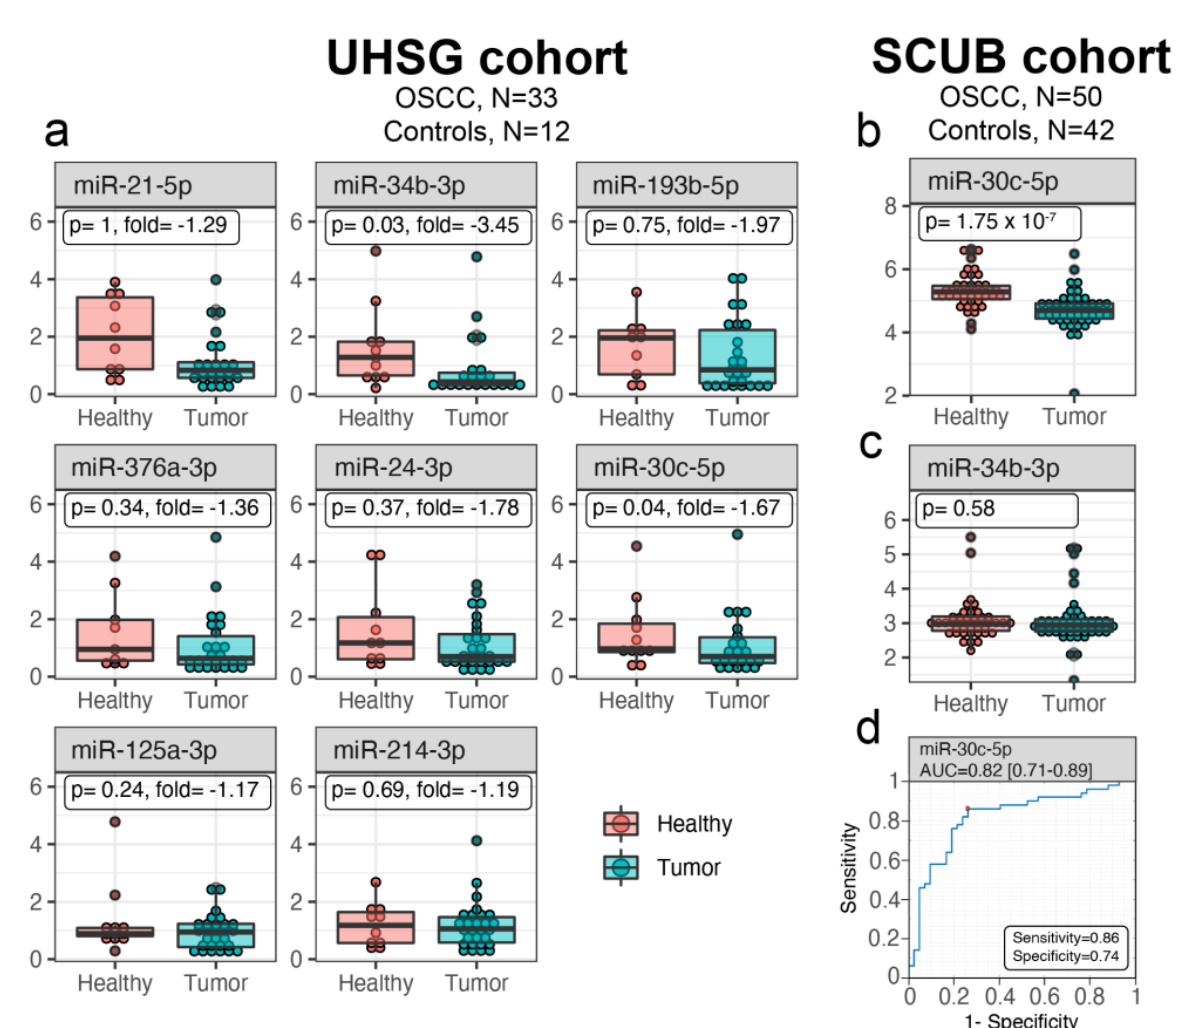
Figure 1. miR-30c-5p is depleted in OSCC saliva and can be used for differentiation of cancerous from normal patients. ( a ) Box plots of miR-21-5p, miR-34-3p, miR-193-5p, miR-376a-3p, miR-24-3p, miR-30c-5p, miR-125a-3p, and miR-214-3p expression, evaluated in both OSCC and normal saliva from the UHSG cohort. Expression levels were determined by TaqMan assay after total RNA extraction from saliva and presented as fold difference. Data are summarized from two technical replicates for each patient. Box plots showing expression levels of miR-30c-5p ( b ) and miR-34-3p ( c ) in normal control and OSCC saliva from the SCUB cohort. The expression was measured by miRNA microarray assay on RNA obtained from each sample of tumoral and normal saliva and presented as fold difference. ( d ) Diagnostic performance of miR-30c-5p for OSCC. ROC curve analysis of salivary miR-30c-5p in discriminating between patients and healthy individuals from the SCUB cohort. The red square indicates the optimal cutoff threshold value for diagnosis. Usually, saliva is in direct contact with the oral cancer tissues. Moreover, the tumor cells secrete a variety of molecules, including miRNAs, directly into the saliva.